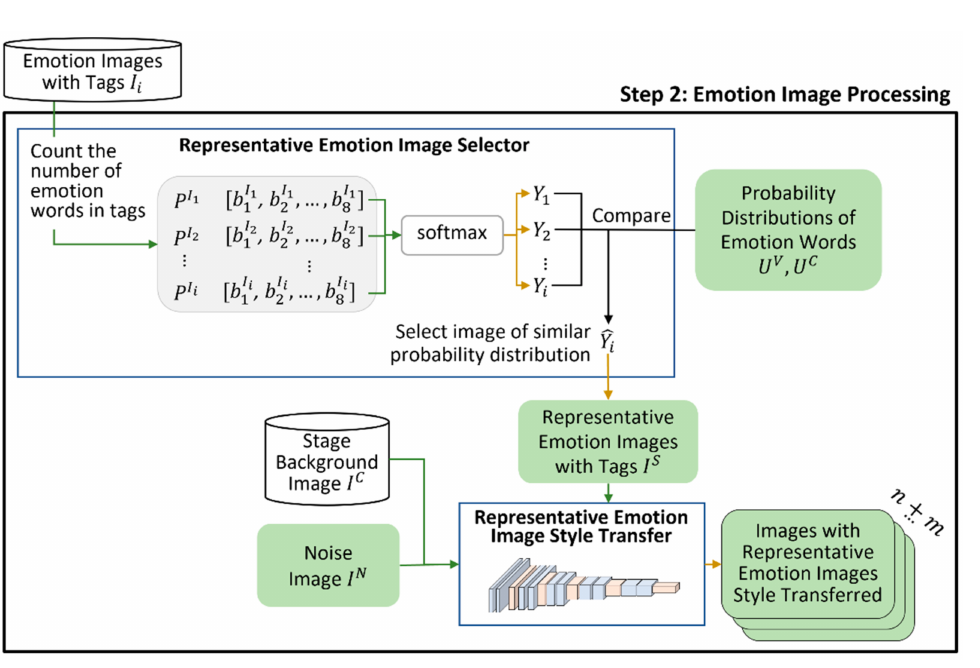
Figure 4. Step 2: Emotion image